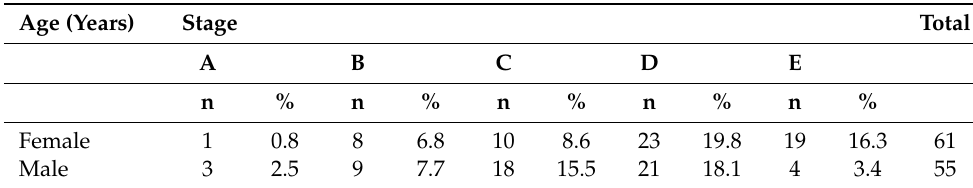
Table 6. Distribution and comparison of the MPS maturational stages in 10- to 25-year-old subjects by sex.